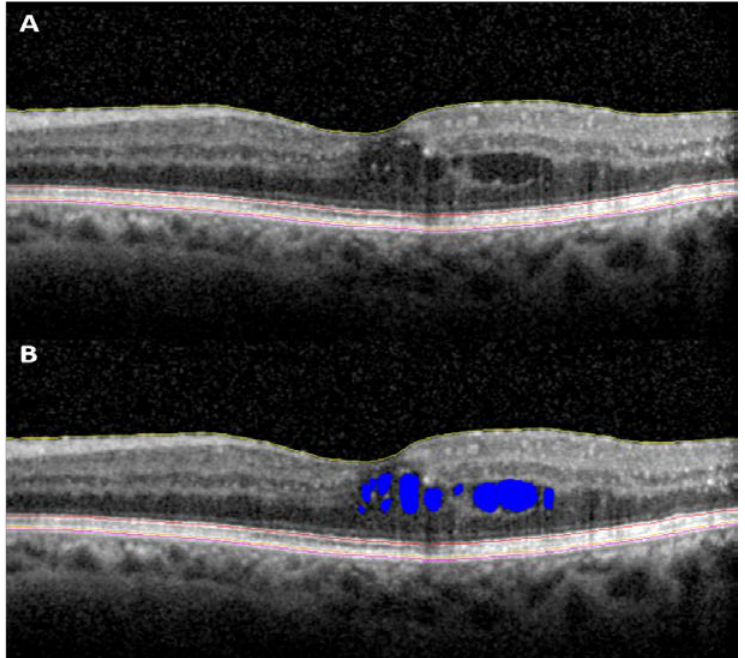
Figure 2. Spectral domain OCT scan of a patient with diabetic macular edema. ( A ) B-scan showing segmented retinal layers and ( B ) B-scan showing segmented retinal layers and intra-retinal fluid (shown in blue). OCT: optical coherence